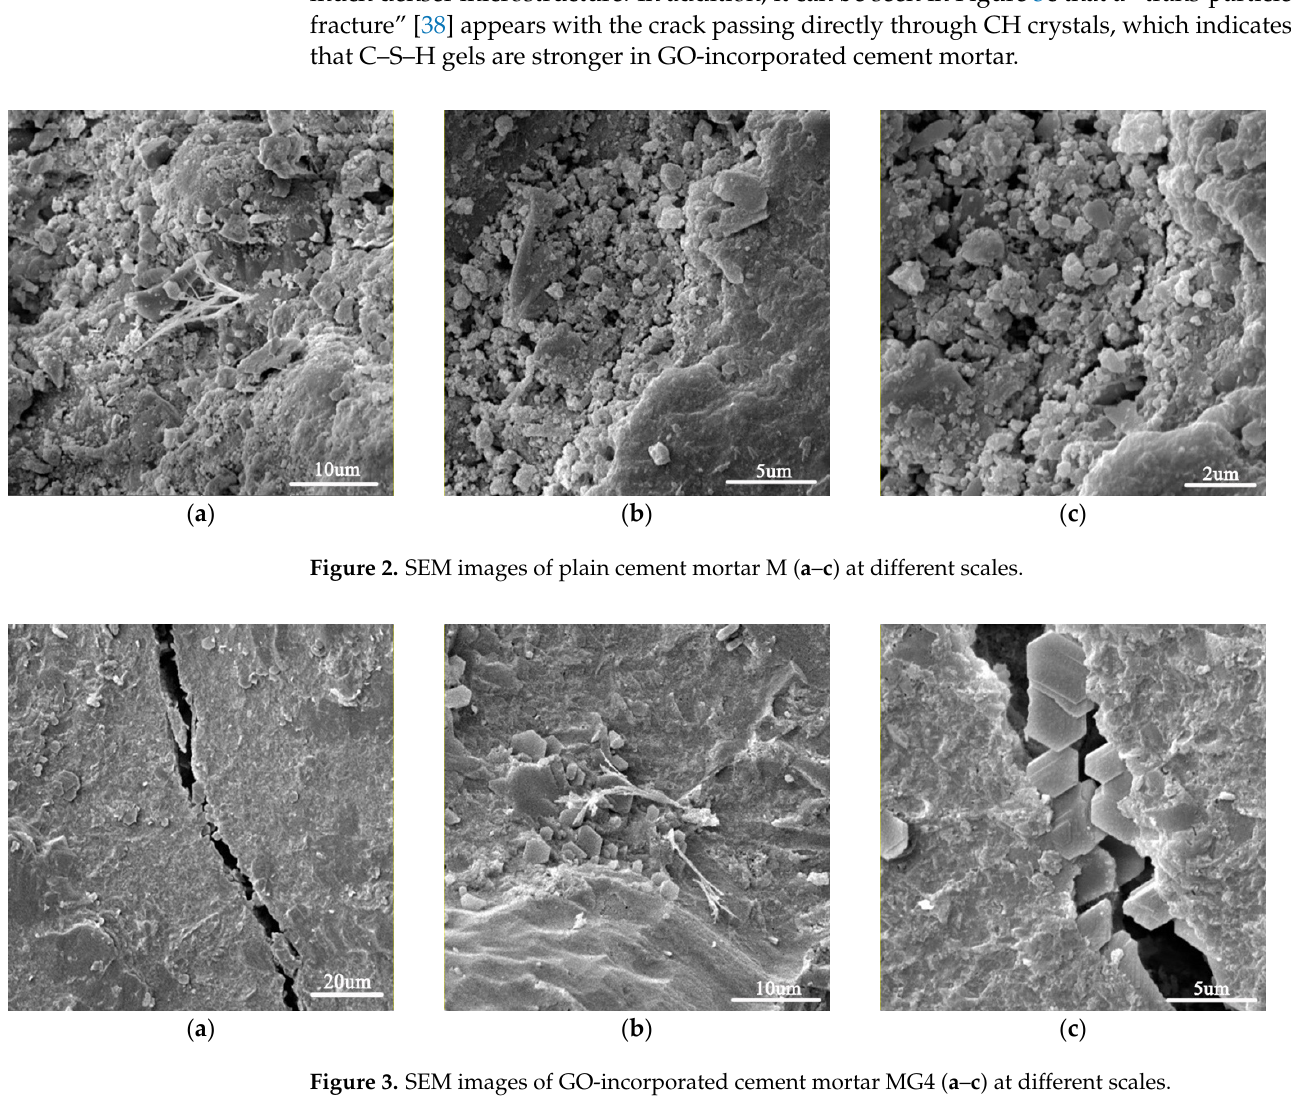
( c ) Figure 4. SEM images of an ITZ in sample MG4 ( a – c ) at different scales. 3.2. Observations of Layer-to-Layer Interface The hardened samples were cut along four planes after casting for 7 days, as shown in Figure 5, to examine the final shape of the samples. Cuts 1 and 3 were the vertical planes in the longitudinal and lateral axes of the center of each sample, respectively. Cut 2 was a transverse vertical plane 40 mm (a quarter of the total length of the sample) from one end of the sample, whereas Cut 4 was at the same distance (40 mm) from the other end of the sample.